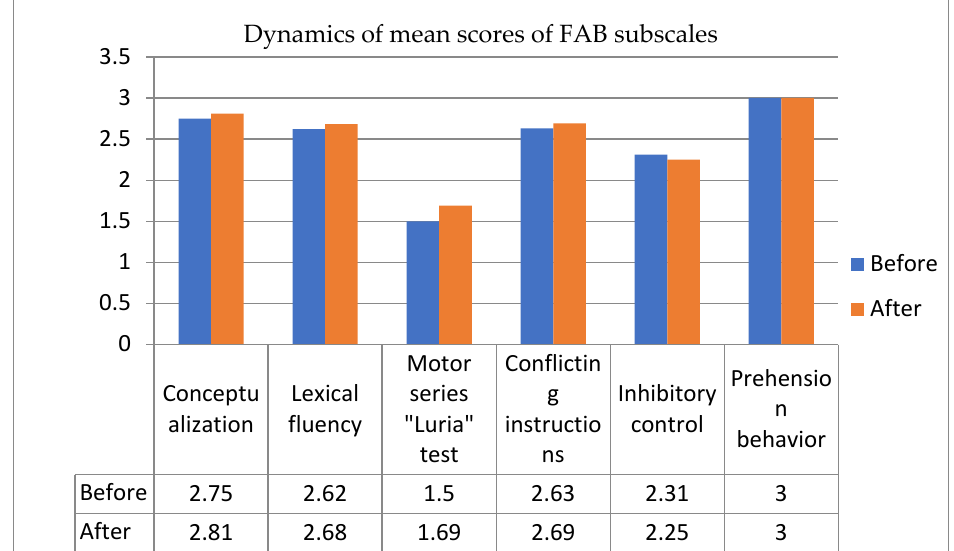
Figure 3. Dynamics of mean scores of FAB subscales before and after the training (did not differ significantly).